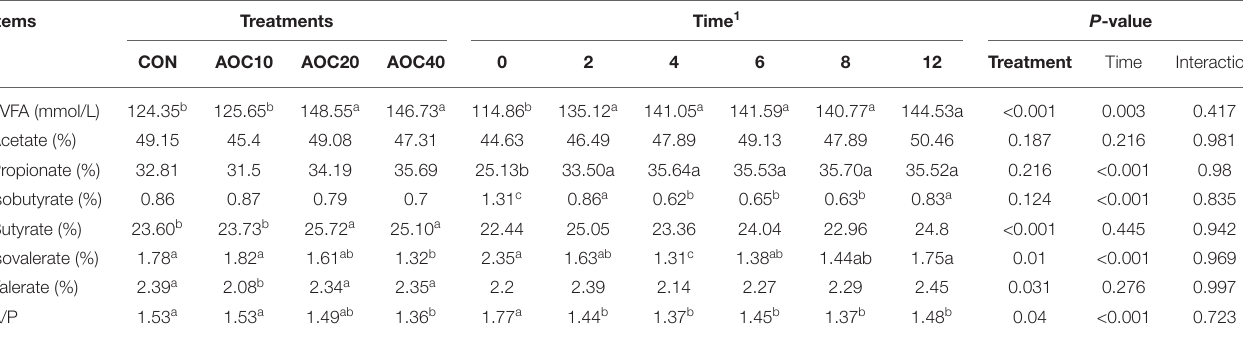
TABLE 4 | Effects of different dietary levels of Aspergillus oryzae culture supplementation on ruminal VFA composition of Hu sheep. Items Treatments Time 1 P -value